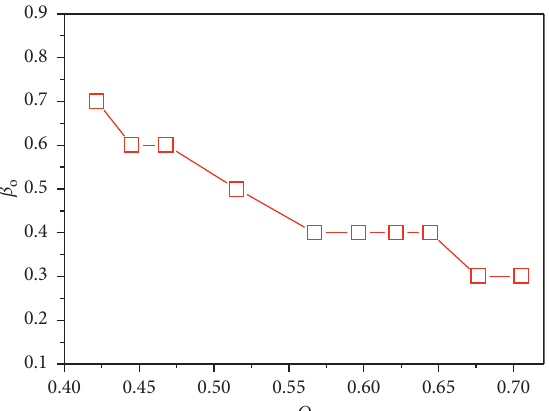
Figure 5: The optimal parameter β o as a function of the modularity coefficient Q on the ICNs with ER-ER